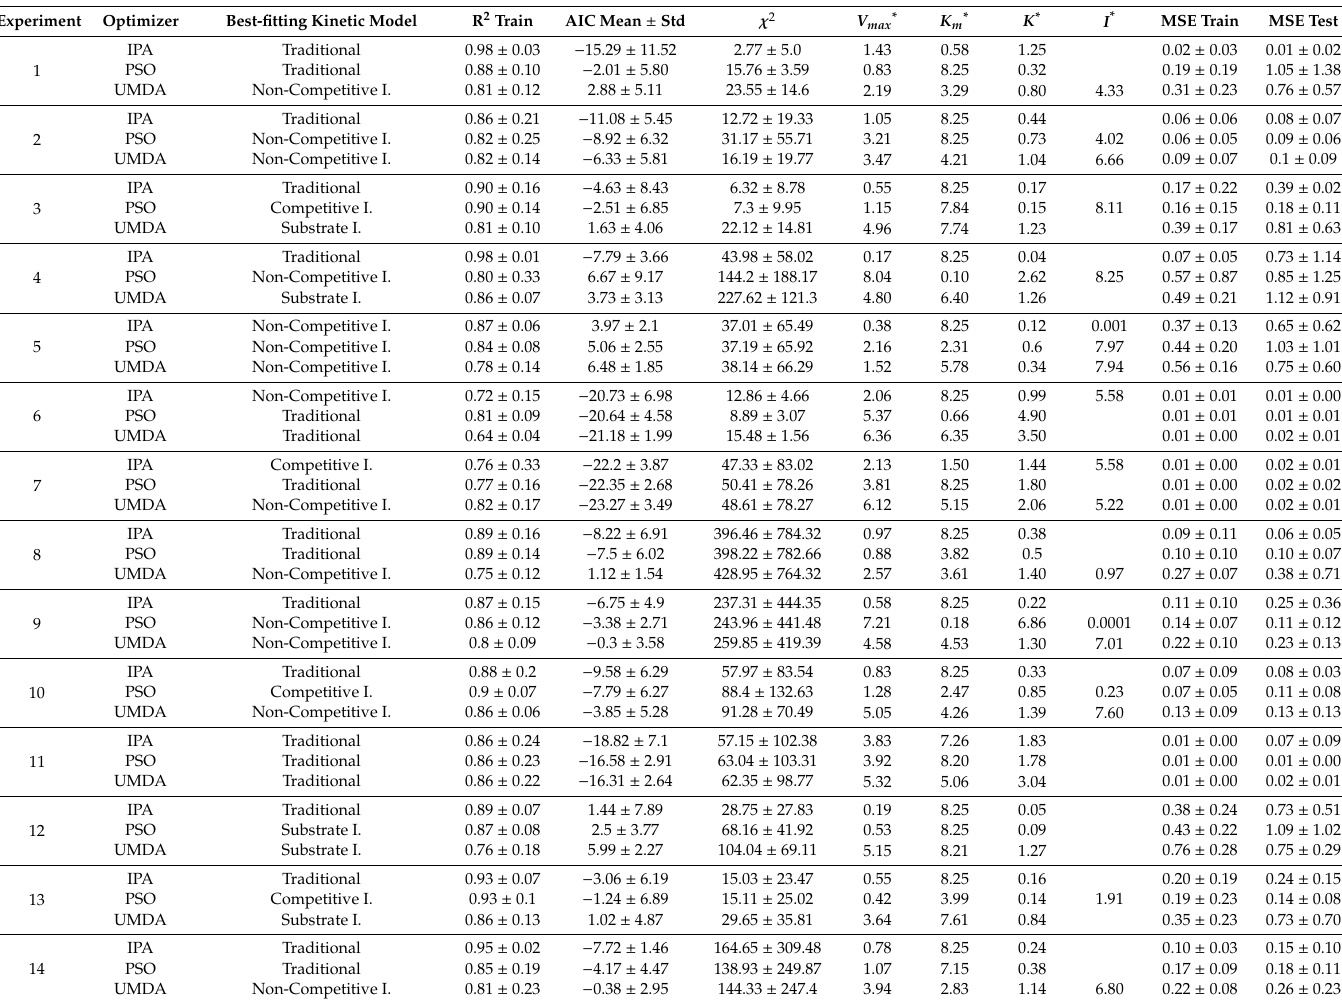
Table 2. Best-fitting models and parameters found by optimizer: Interior-Point Algorithm (IPA), Particle Swarm Optimization (PSO) and Univariate Marginal Distribution Algorithm (UMDA). V max (mg / mL × s), K M (mg / mL), I (mg / mL). MSE: mean square